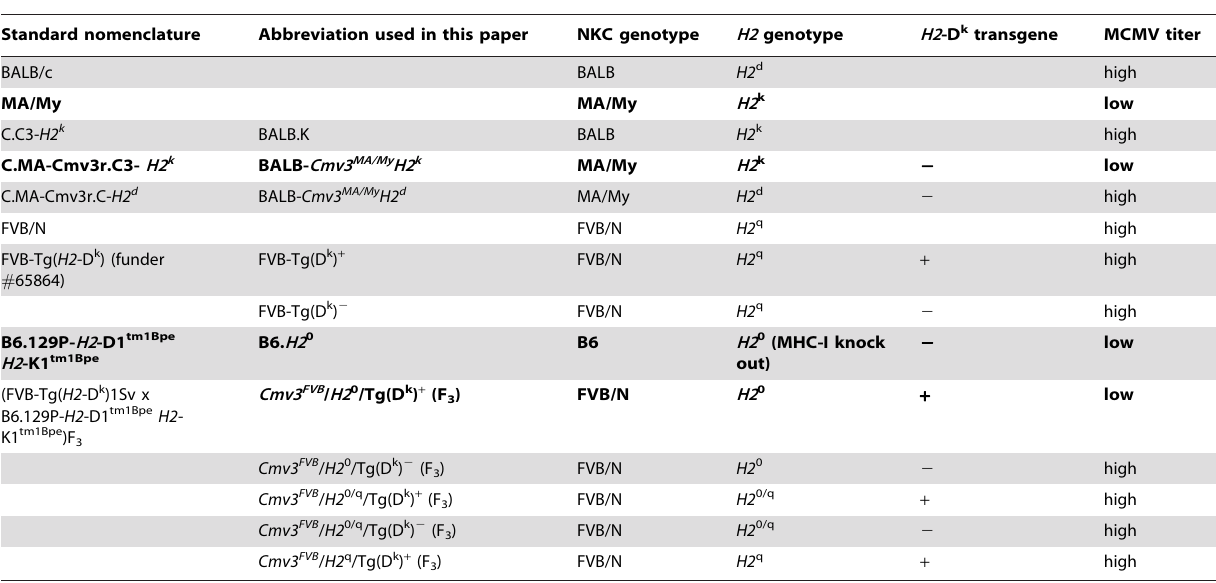
Table 1. Nomenclature, NKC/ H2 genotype, and MCMV titer of mouse strains used in this